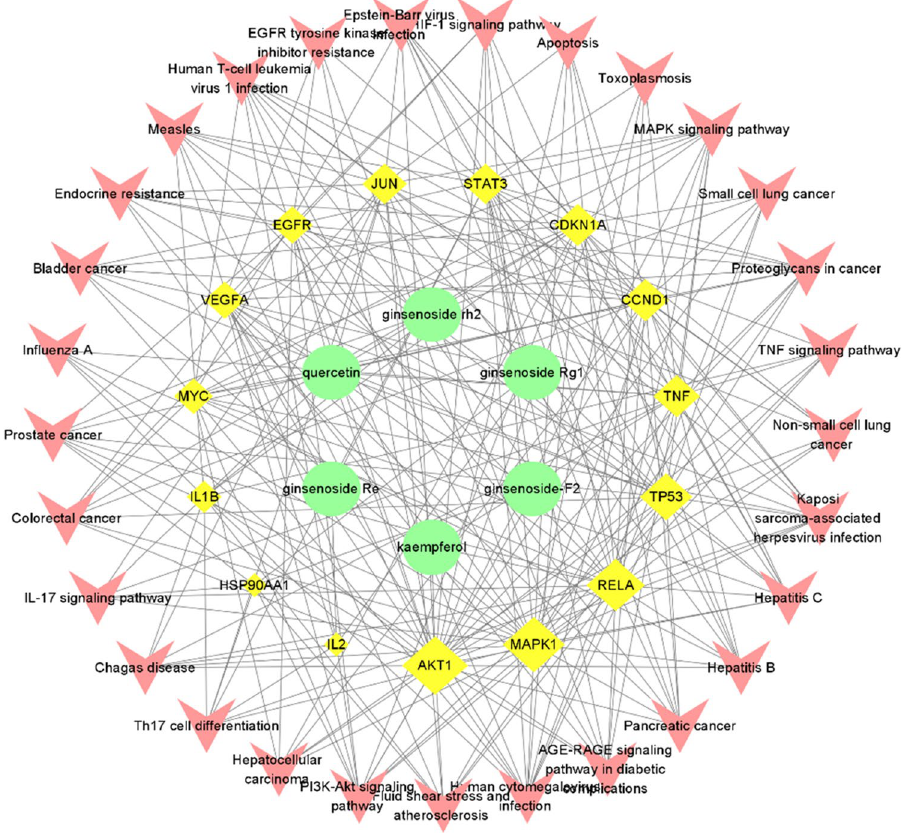
Figure 6. The “active components-target genes-pathways” network.